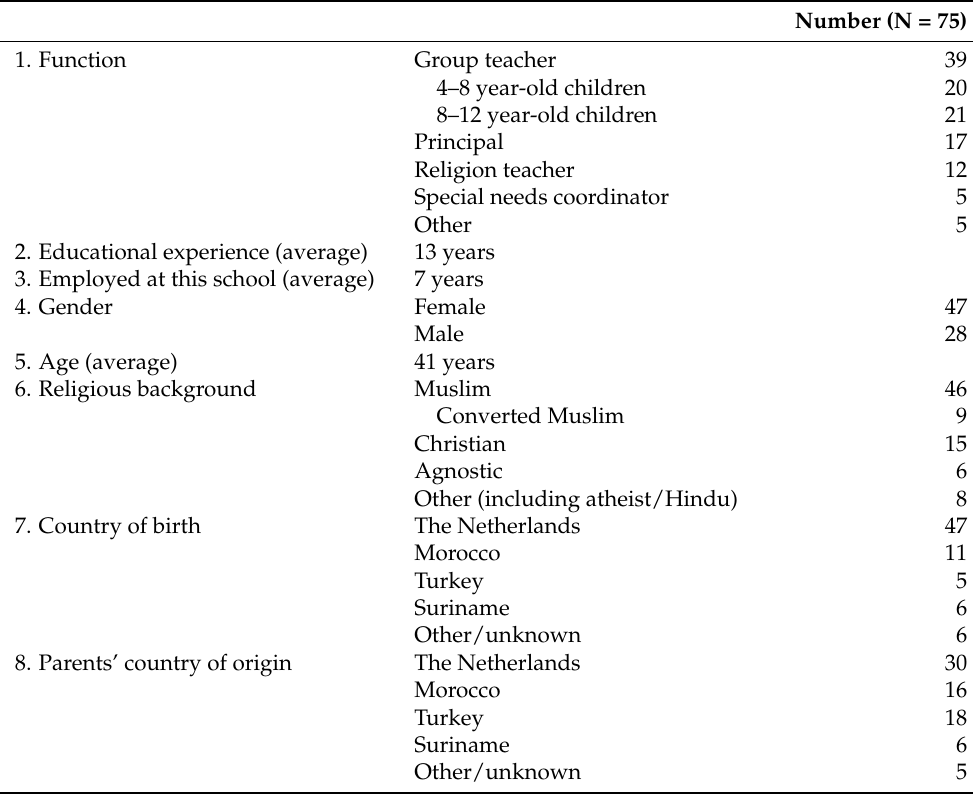
Table 1. Respondents’ background characteristics.